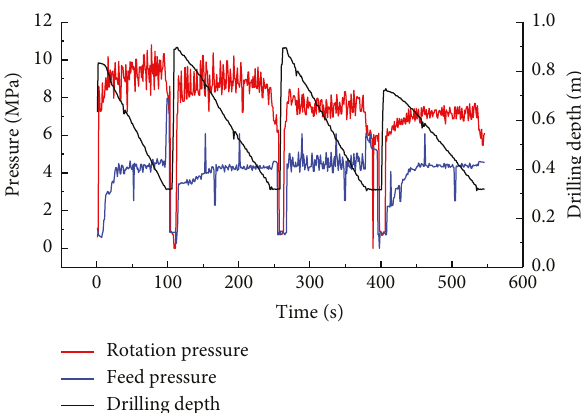
Figure 8: Typical curves of parameters during a drilling cycle.